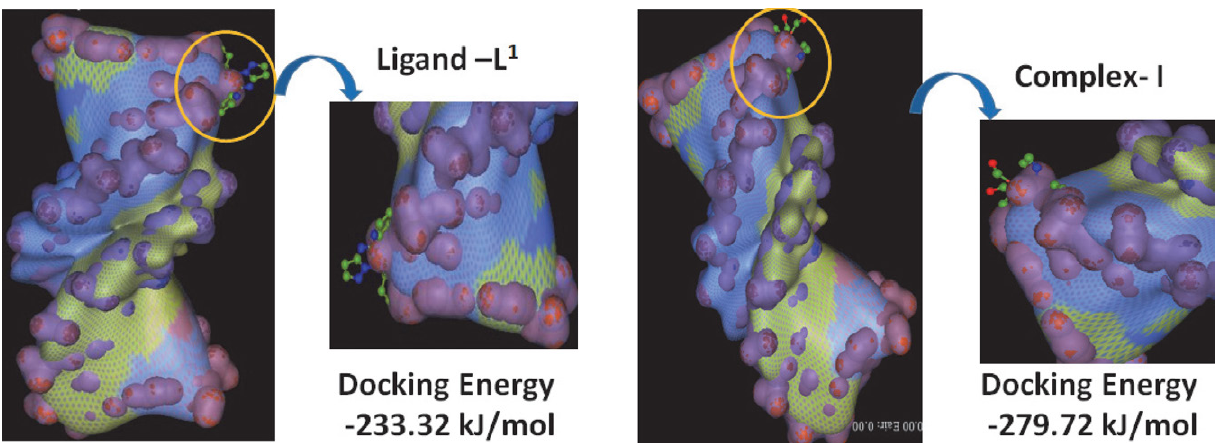
Figure 7. Molecular docking of complex I (ball and stick) with the DNA duplex (VDW spheres) of sequence d(CGCGAATTCGCG) 2 . The complex is docked inside the DNA groove.